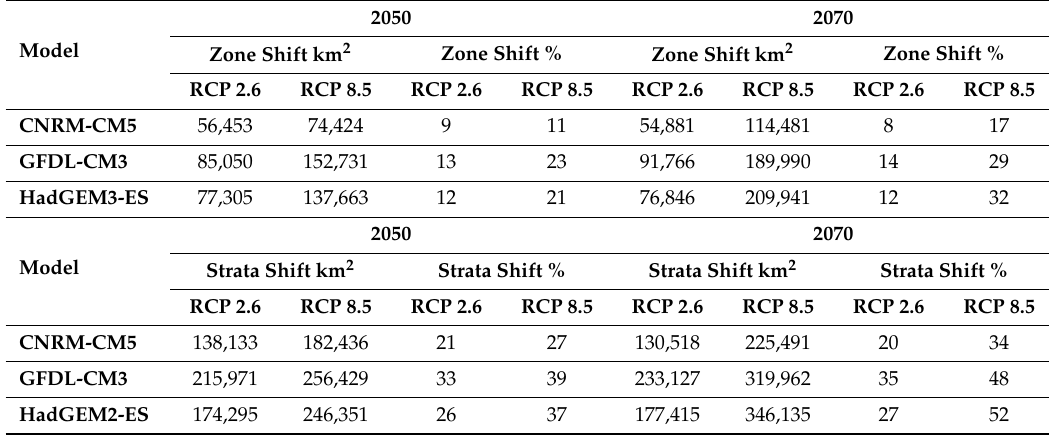
Table 3. Land area and percentage of total land area in Myanmar that is projected to change its bioclimatic zone or stratum by 2050 and 2070, with three earth system models and two RCPs.